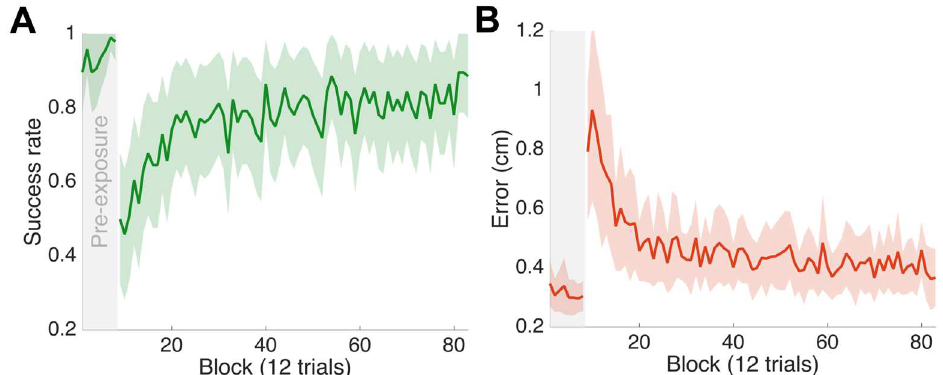
Fig 2. Performance in Experiment 1. (A) Success rate across blocks shown as mean ± s.e. across subjects. The success rate was the proportionof trials in which subjects placedthe cursor within the target within 3 seconds of the target appearing.The first 8 blocks are pre-exposuretrials. Each block consists of a movement from each starting location to the central target. (B) Error, the distancebetweenthe target and the final cursor positionat the end of the trial, across blocks in the same format as